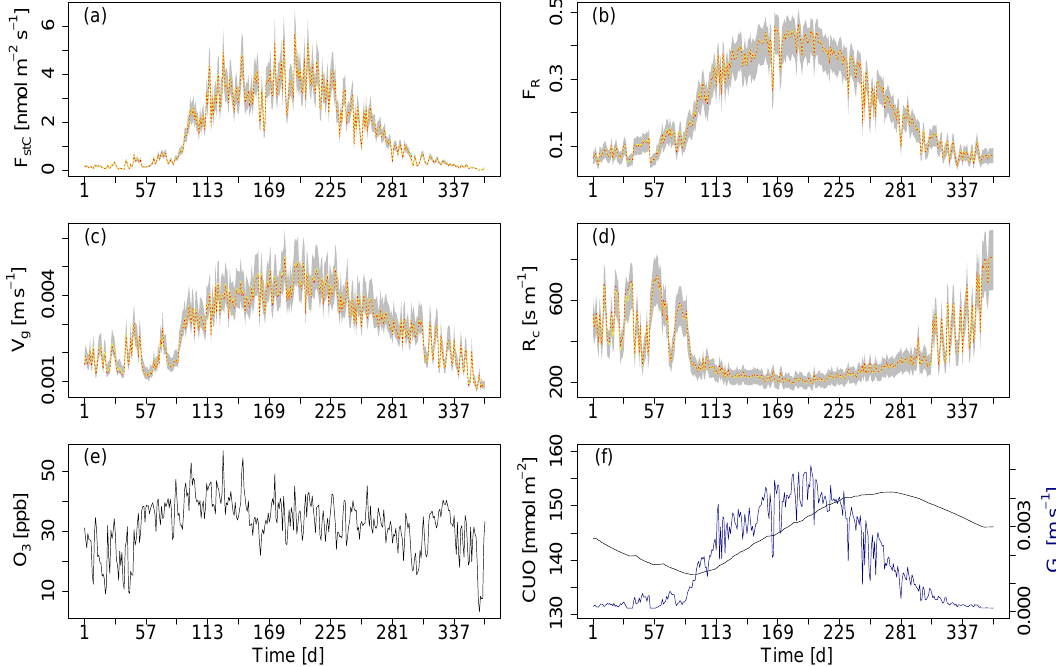
Figure 4. Ensemble range of key O 3 uptake/deposition variables resulting from the perturbation of R a , b , r ext , ˆ R gs , and G c within ± 20% of their central estimate. Shown are simulated daily mean values of (a) O 3 uptake ( F stC ), (b) the O 3 flux ratio ( F R ), (c) O 3 deposition velocity ( v g ) and (d) O 3 surface resistance ( R c ) for the boreal needle-leaved evergreen forest at the finish FLUXNET site FI-Hyy for the year 2001. Red dashed: unperturbed model; yellow: median of all sensitivity runs; light-grey area: min–max range of all sensitivity runs. Simulated daily mean values for the respective site and year of (e) atmospheric O 3 concentrations O 3 and (f) cumulative uptake of O 3 (CUO) and canopy conductance G c